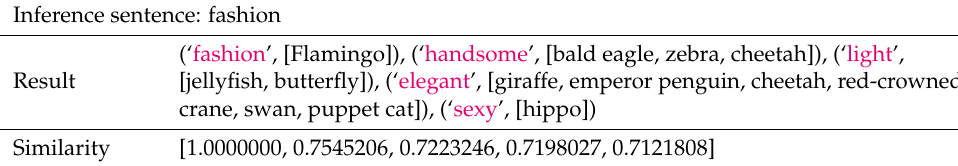
Figure 5. Bionic night light design reference, concept sketch and rendering effect. Table 14. Semantic reasoning result of affective perception.